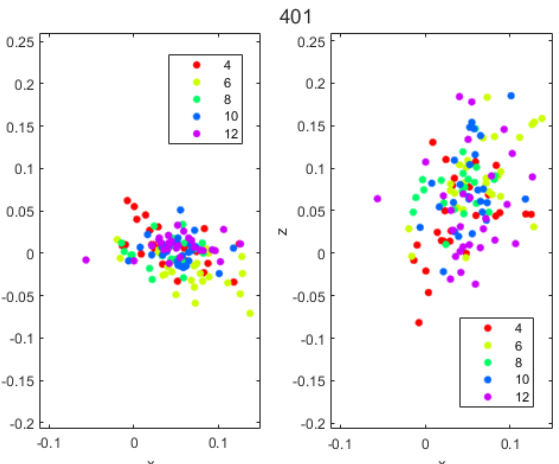
Figure 10. Scatter plot of the residuals for benchmark 401, for all the operators and all the considered rover-façade distance values.